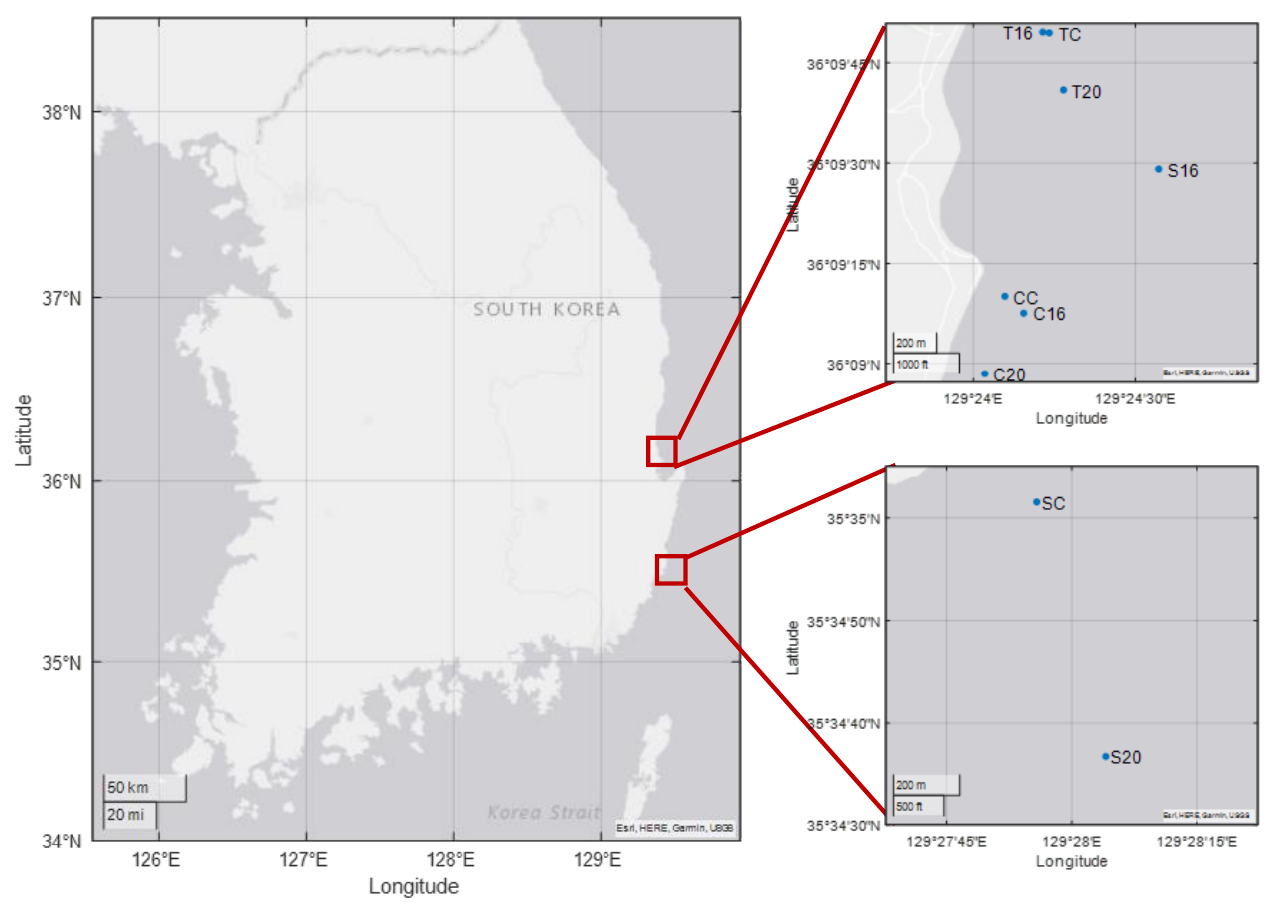
Figure 1. Location of the AR and control sites. Table 2. Standards for concentration of HMs in seawater and marine